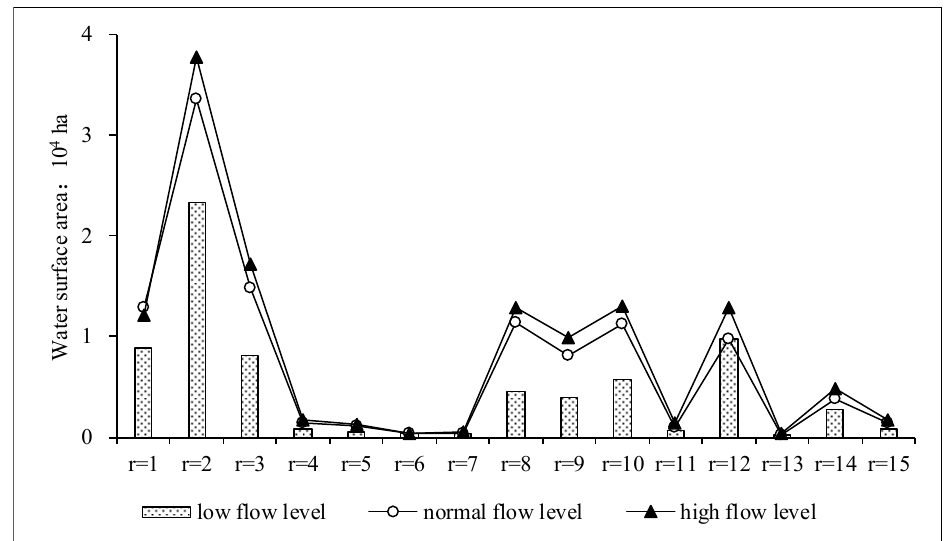
Figure 12. Sizes of restored water surface area based on model 2 in the western Jilin Province under different scenarios.